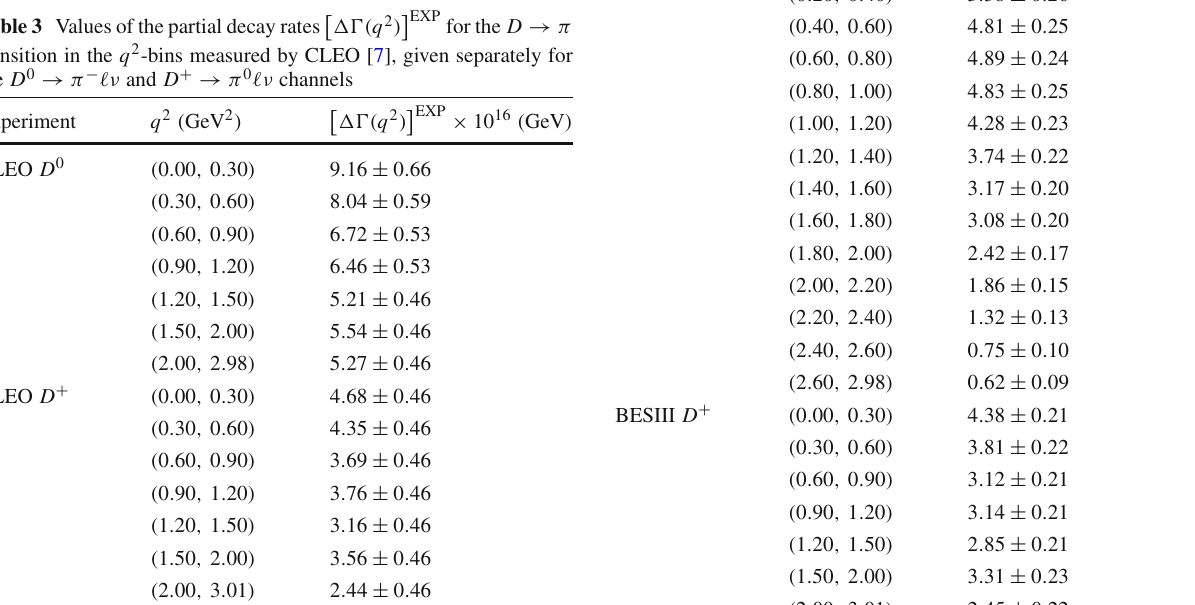
(cid:10) (cid:11) EXP for the D → π (cid:6)(cid:5)( q 2 ) (cid:10) (cid:11) EXP × 10 16 ( GeV ) (cid:6)(cid:5)( q 2 )